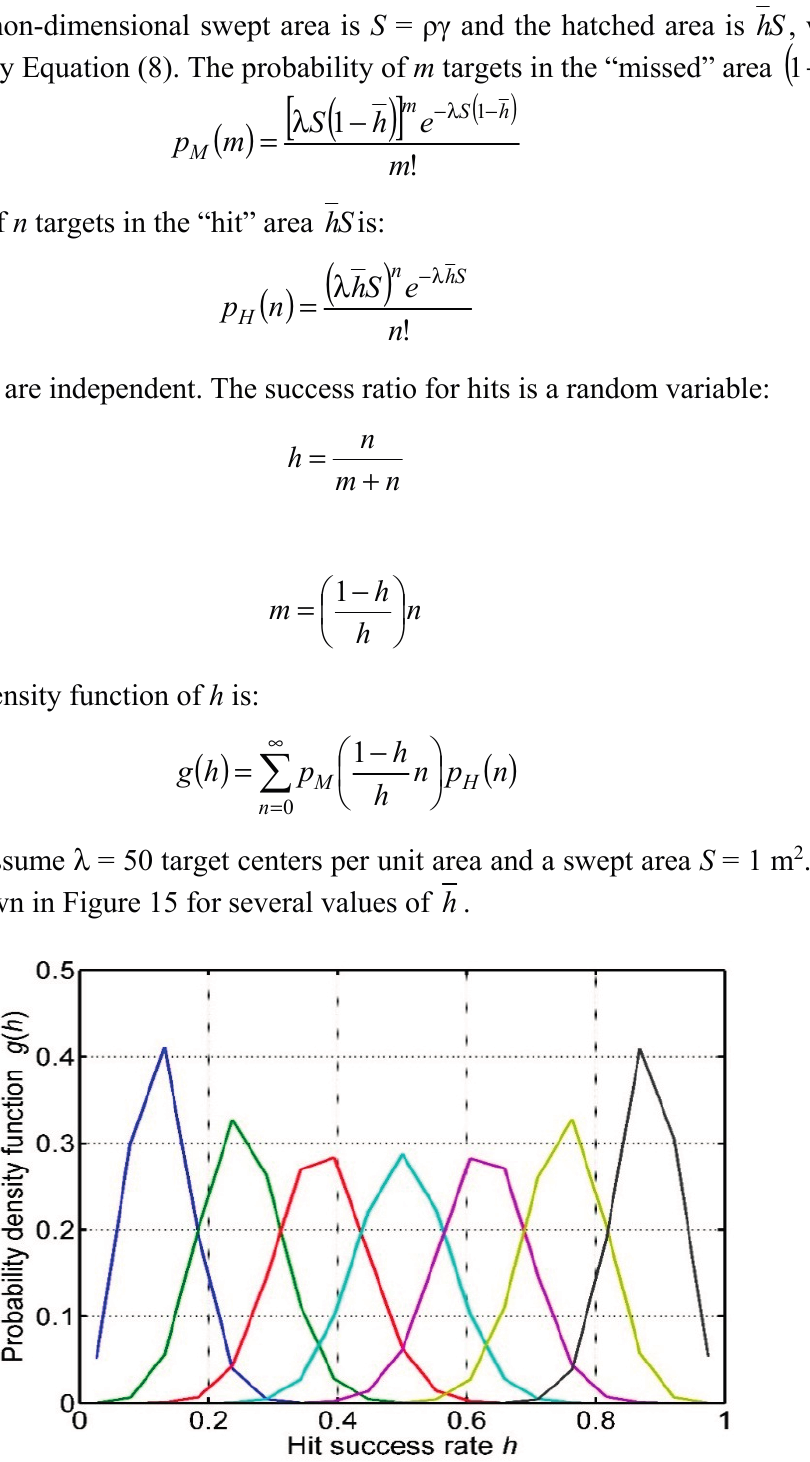
Figure 15. The probability density function for hit success rate h from Equation (12) for seven values of h